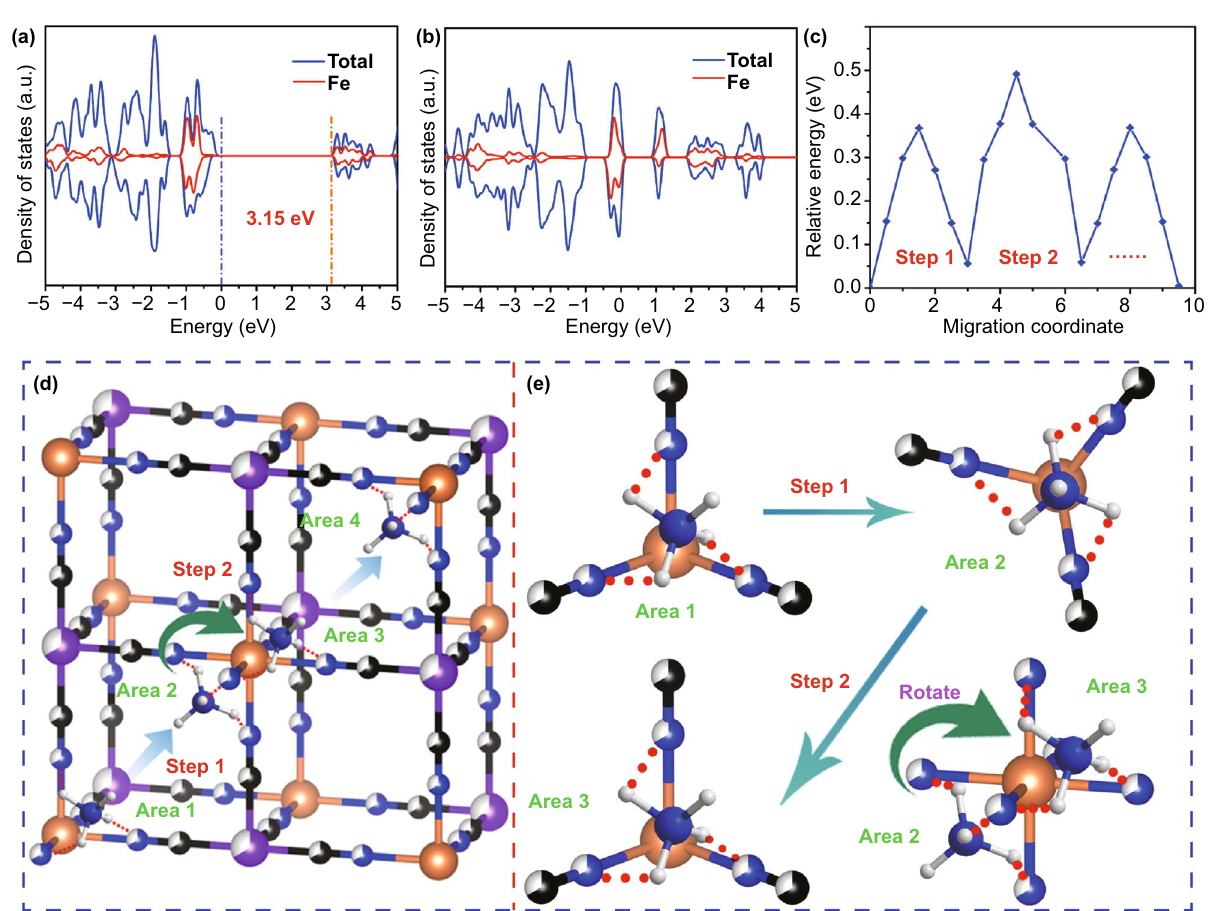
Fig. 6 a‑b Density of states for Fe atom in pristine and ammoniated CuHCF. c Changes of diffusion activation energy during ammoniation/de- ammoniation progresses. d Schematic illustration of NH 4+ diffusion from 48 g site to another. e Detailed view of NH 4+